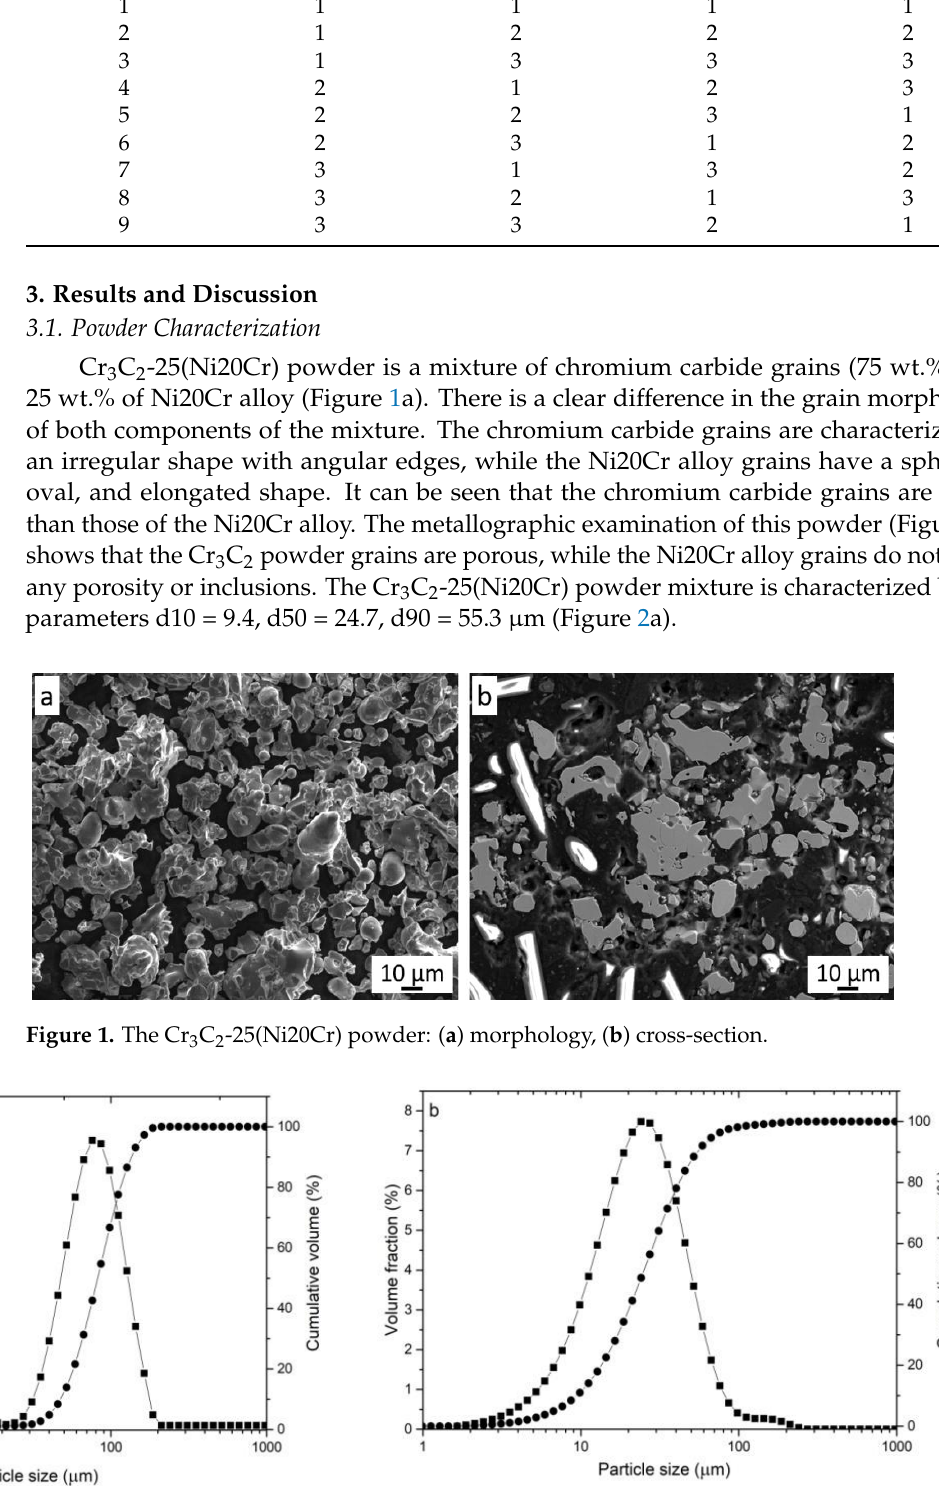
Table 2. Taguchi orthogonal L 9 (3 4 ) design matrix.